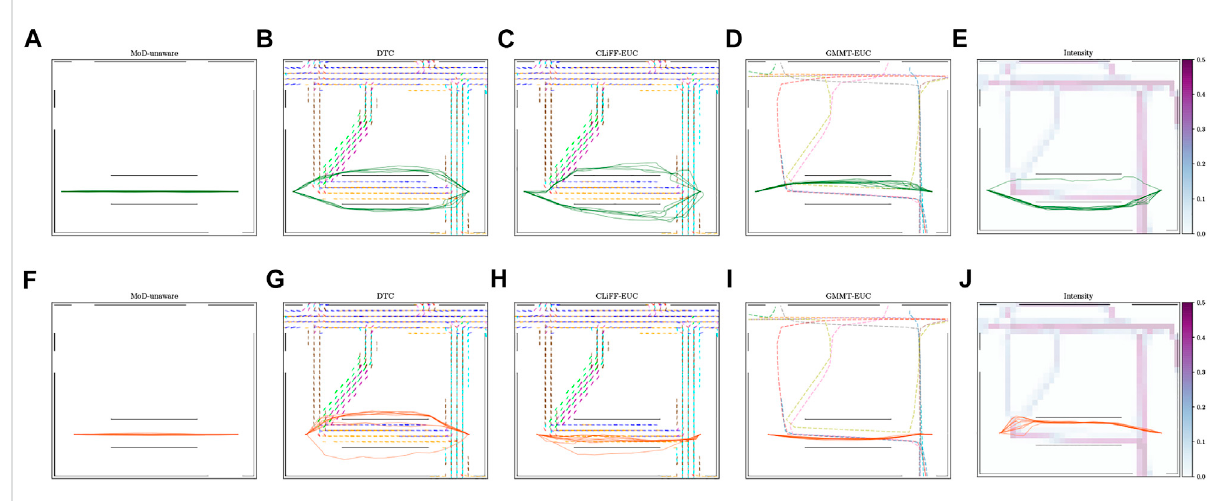
FIGURE 13 Paths generated by different planners and related MoD mapfor Scenarios 1 (A – E) and 2 (F – J) inthe PedSim warehouseenvironment. Column- wise from left to right: MoD-unaware planner, DTC, CLiFF-EUC, GMMT-EUC, Intensity.